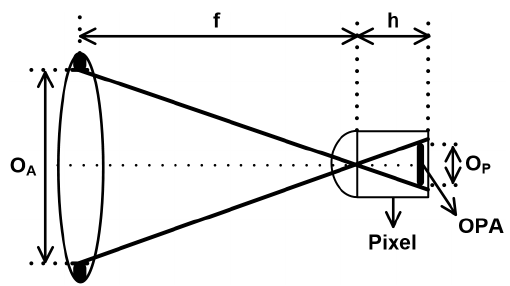
Figure 3. The geometric model of the OPA technique.